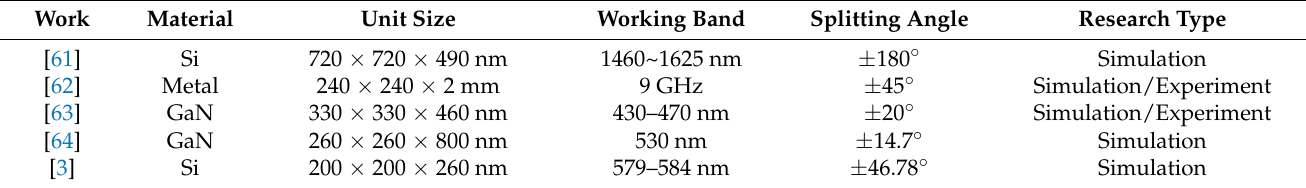
Figure 5. ( a ) Schematic diagram of the unit cell of GaN nanobricks [64]. ( b – g ) The transmitted light intensity distribution under the polarization state of the incident light, respectively, 0 ◦ ( x -polarization), 30 ◦ , 42 ◦ , 45 ◦ , 60 ◦ , and 90 ◦ ( y -polarization) incident light [64]. ( h ) Schematic diagram of the metasurface and unit cell of the cruciform structure [3]. ( i ) Schematic diagram of beam–splitting capability and beam–splitting angle [3]. Table 1. Parameters of circular linear metasurface beam splitters described in this section.